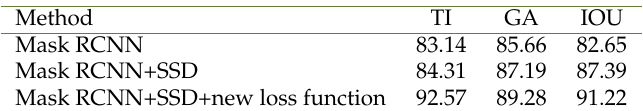
Table 3. Ablation experiment